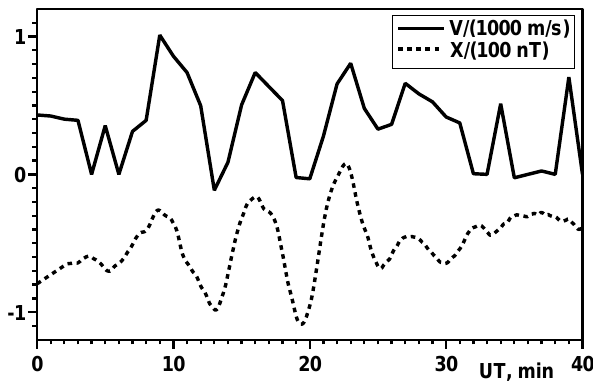
Fig. 8. Velocity (normalised by 1000m/s) in the ionospheric F - region recorded by the Saskatoon radar (beam 14) at the latitude of Fort Churchill and magnetic X -component data (normalised by 100nT) from Fort Churchill.